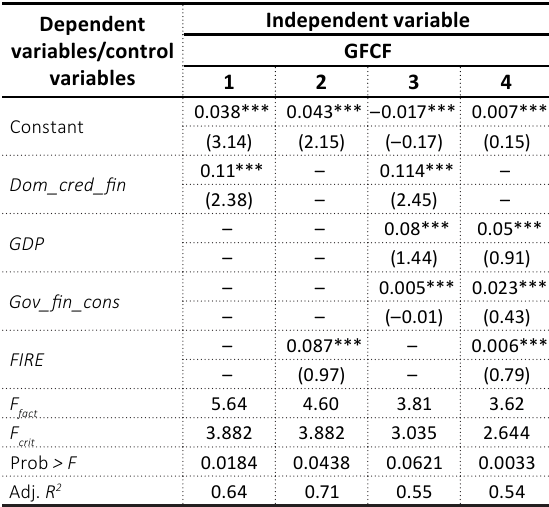
Table 6. Results of identifying the dependence between IMFR indicators and amount of gross fixed capital formation